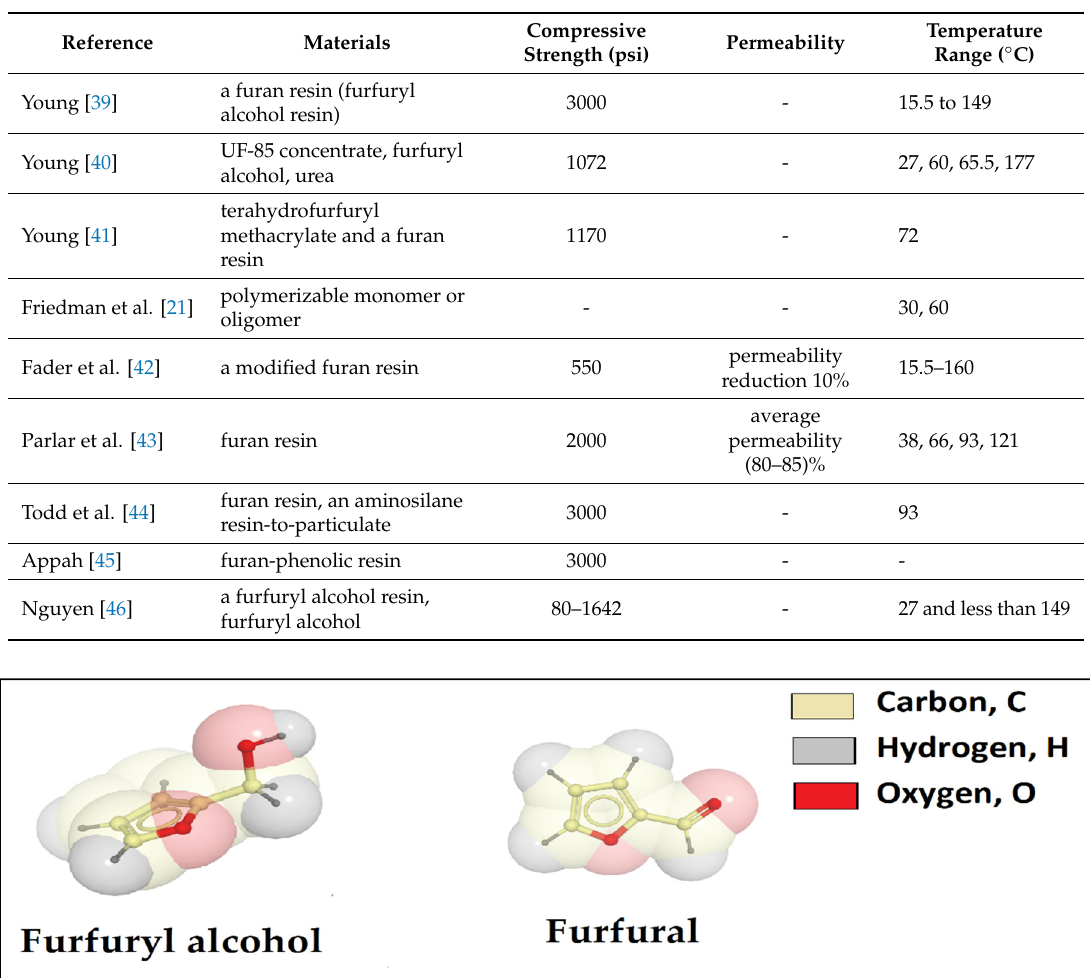
Table 3. Furan resin methods to control sand formation.